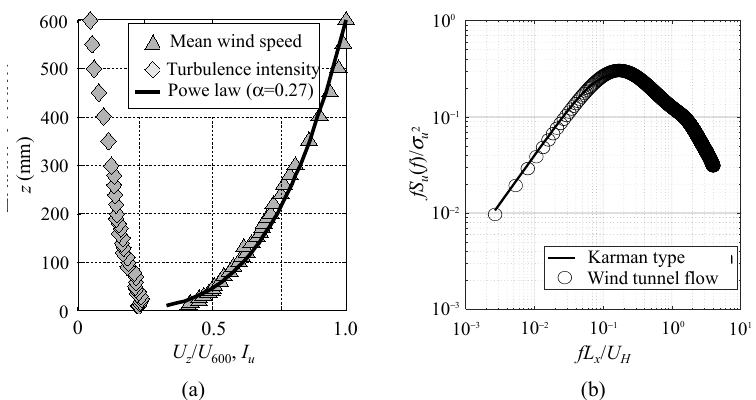
Figure 4. Characteristics of wind tunnel flow: ( a ) Profiles of mean wind speed U z and turbulence intensity I u ; ( b ) non-dimensional power spectrum of fluctuating wind speed at a height of z = 10 cm.